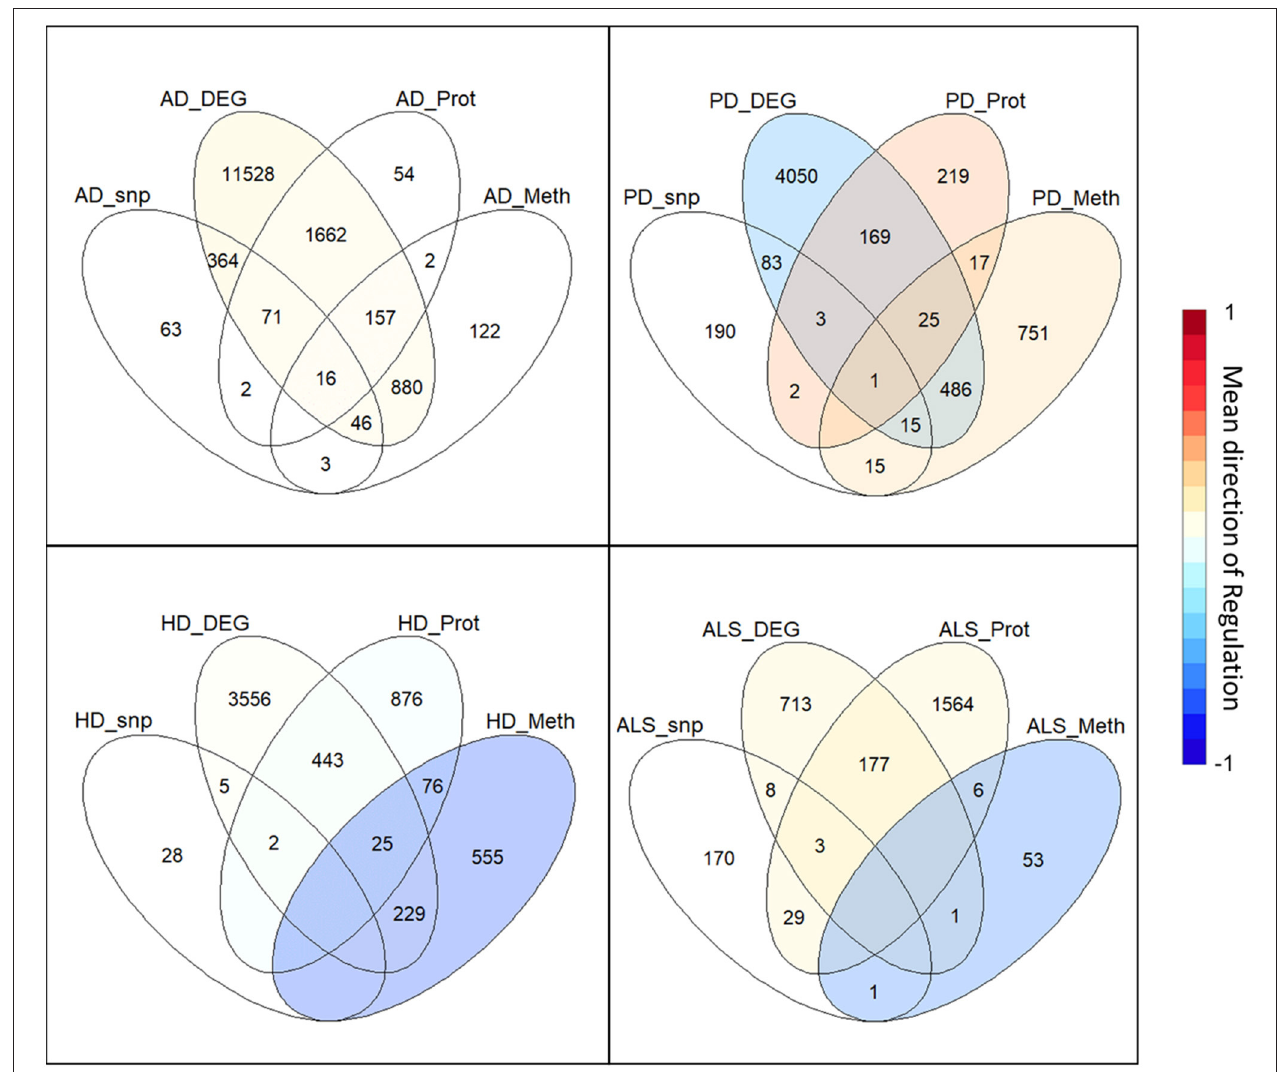
FIGURE 1 | Omics-layer intersections per disease: The Venn diagrams for the four NDDs, AD, PD, HD, and ALS are shown with the numbers of shared genes in the intersections of the specific omics-layers. Additionally, the transcriptomic, proteomic, and methylomic layers of each NDD are colored to give each layer’s mean direction of regulation. This color represents the color of only the respective layer, not of the individual intersections, as those have a specific regulation for each omics-layer.